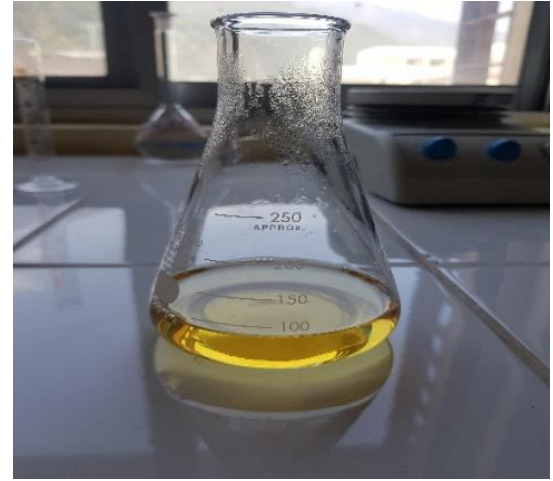
Figure 1 Debregeasia salicifolia leaf extract. Figure 1. Debregeasia salicifolia leaf